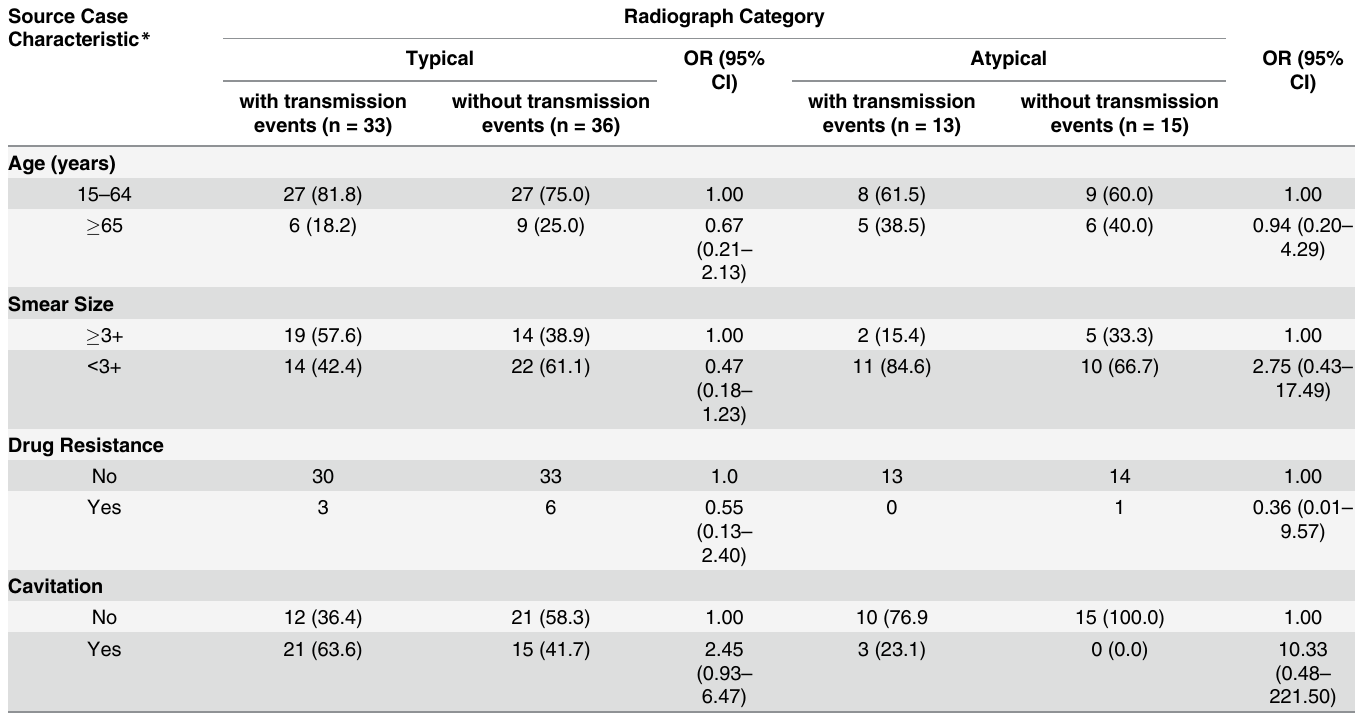
Table 7. Transmission events by source case characteristic and chest radiograph